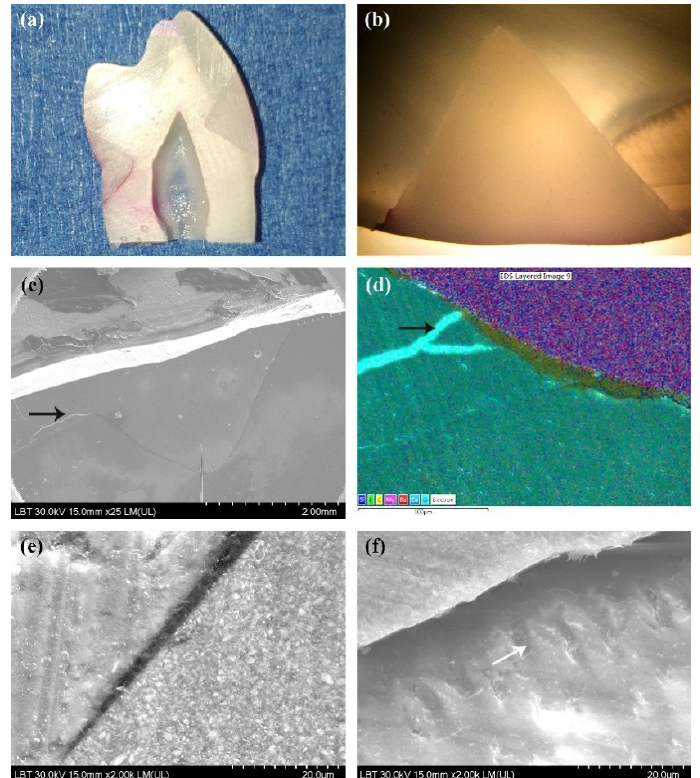
Figure 5. Dynamic Plus ® restoration. Infiltrated cervical area of the cementum-located restoration on the tooth section (left) ( a ), optical microscopy ( b ), and SEM image (upper-right) (25×) ( c ). Cracked occlusal enamel on energy-dispersive X-ray analysis (EDX) image (500×) ( d ) not interfering the adhesive layer of 2–6 µ m (2000×) ( e ). Well-designed resinous rete-tags of about 2 µ m and adhesive layer of 6–8 µ m (2000×) ( f ). Black arrow = cracked enamel; white arrow = resin tag.